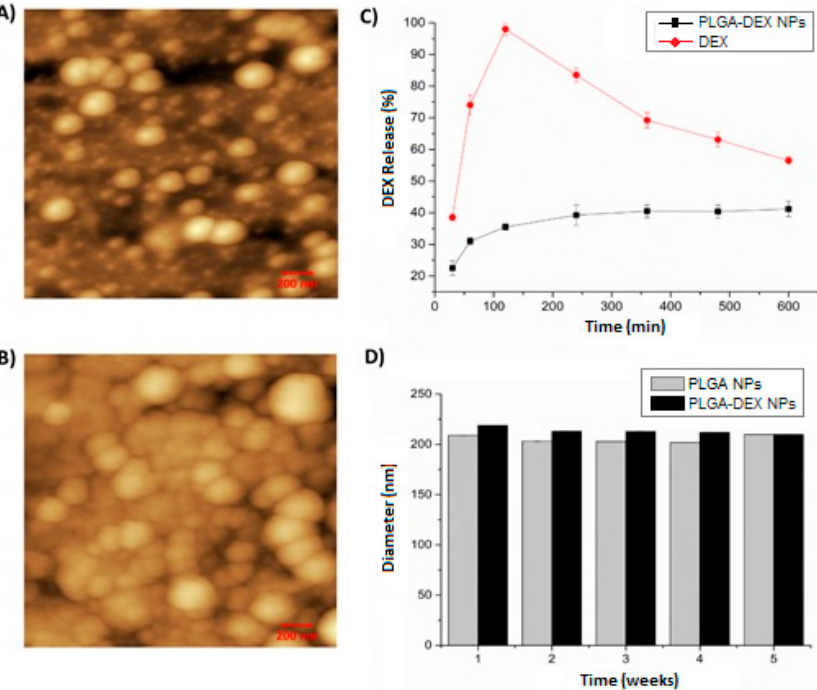
Figure 1. Atomic force microscopy (AFM)—2D images—200 nm scale. ( A ) The nanoparticle of poly( D , Lactic- co -glycolic) nanoparticles (PLGA NP). ( B ) dexamethasone-loaded poly ( D , Lactic- co -glycolic) nanoparticles (PLGA-DEX NP). ( C ) In vitro release profile of dexamethasone free in solution (DEX) and PLGA-DEX NP. ( D ) Physical stability of PLGA NP and PLGA-DEX NP for 5 weeks.